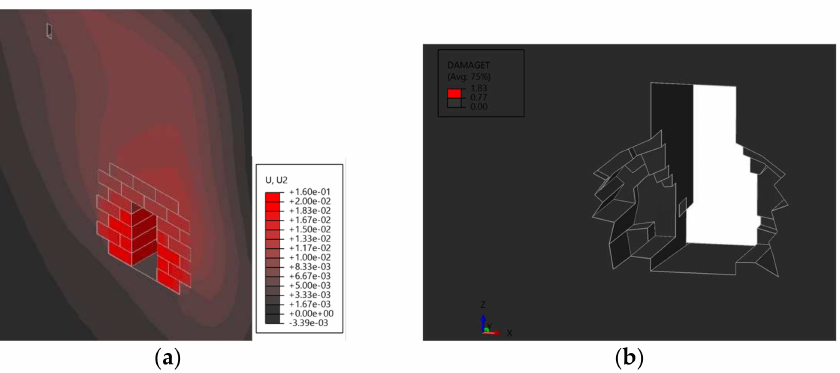
Figure 8. Damage in tension greater than 0.77: ( a ) contact element model; ( b ) removal of damaged